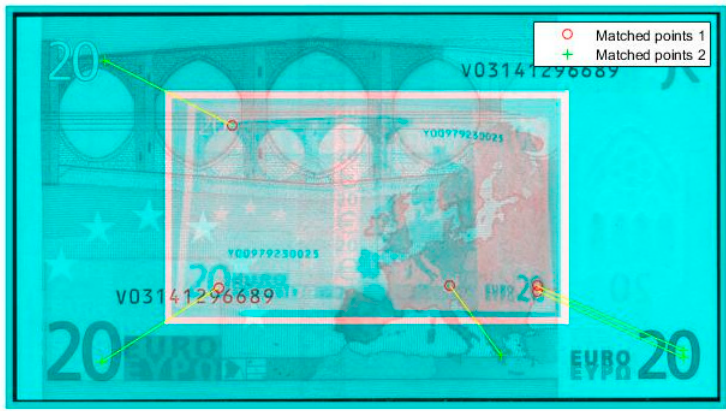
Figure 6. Points of interest matching with Speed Up Robust Features (SURF) method: experiment during the training period with €20 banknote.